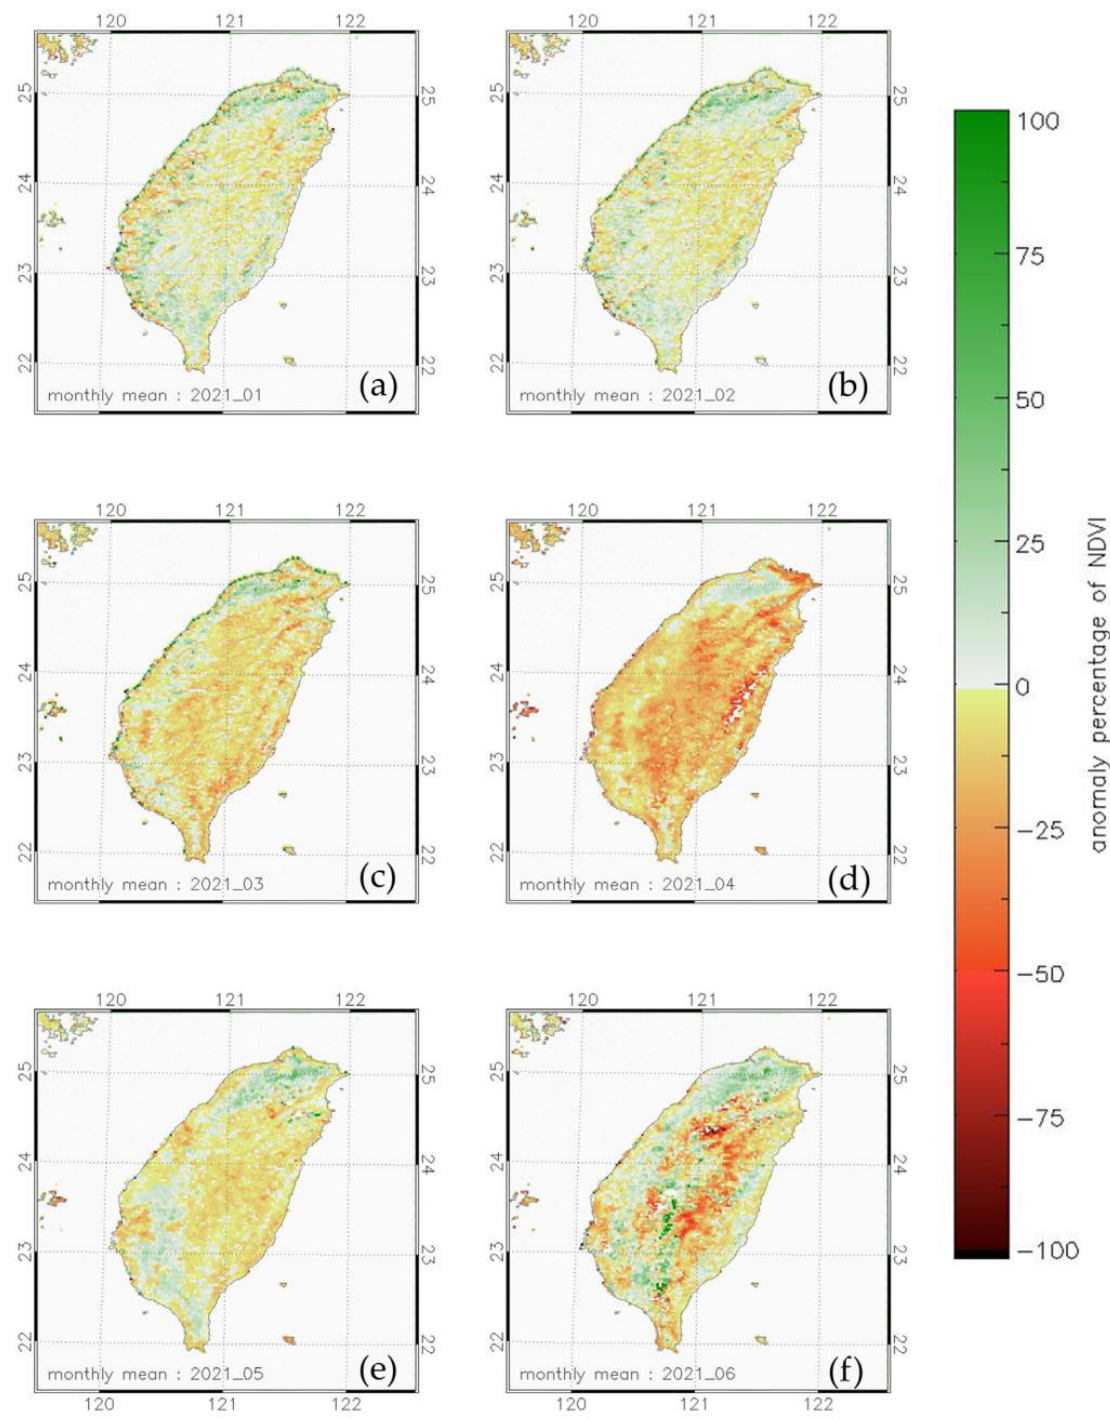
Figure 2. The anomaly of percentage of NDVI over Taiwan from January to June 2021 (from ( a – f )). Color scale is shown at the right.